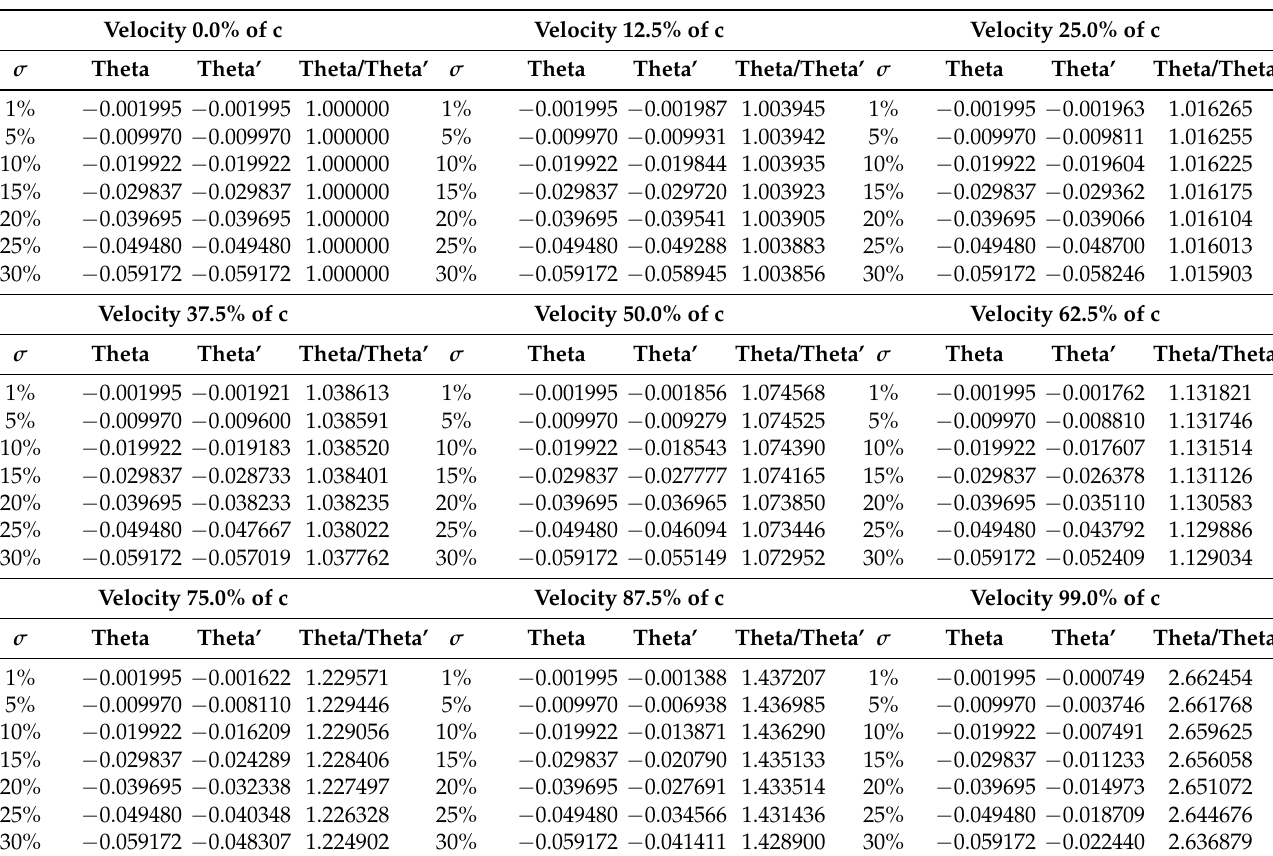
Table 3. Values for Theta , Theta (cid:48) and the ratio Theta / Theta (cid:48) (for a Call or Put), per calendar day, for the volatilities 1.0%, 5.0%, 10.0%, 15.0%, 20.0%, 25.0% and 30.0%, for maturity T = 1 year and for the velocities 0.0%, 12.5%, 25.0%, 37.5%, 50.0%, 62.5%, 75.0%, 87.5% and 99.0% of c . For simplicity, we consider the values at inception t = 0 and r = 0% and both asset prices at inception and strike equal to one S = K = 1. Theta (cid:48) is Theta for a reference frame that is moving and measures less time for velocities >